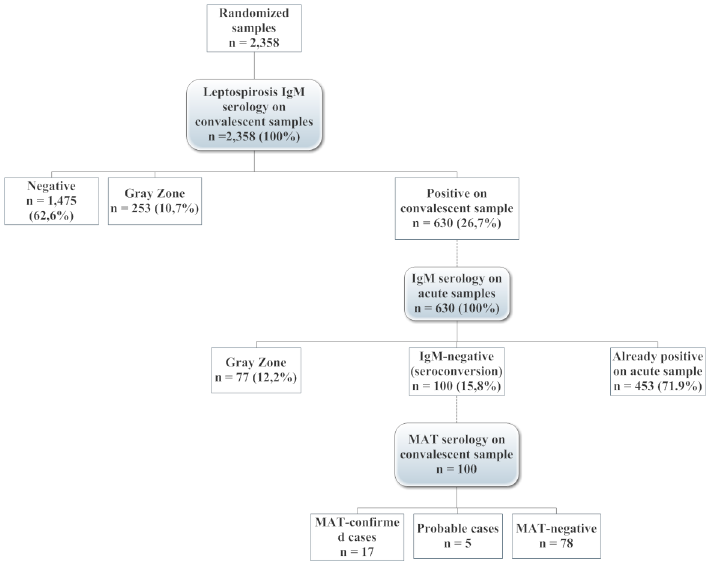
Fig 1. Study flowchart for febrile episodes, 2007 – 2009 rainy seasons, Kampong Cham province, Cambodia. Note: Dotted lines indicate when subsequent tests were performed on different samples for the same febrile